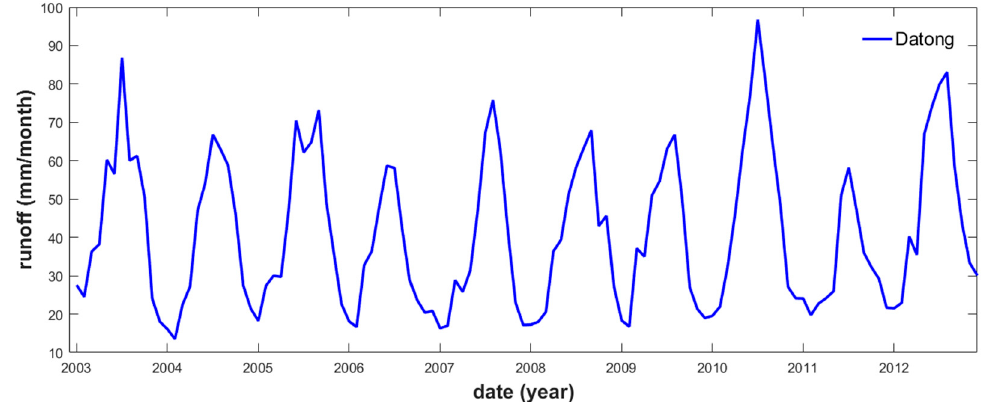
Figure 2. Monthly runoff time series, averaged from the daily discharge data collected at the Datong station (and divided by the basin area).